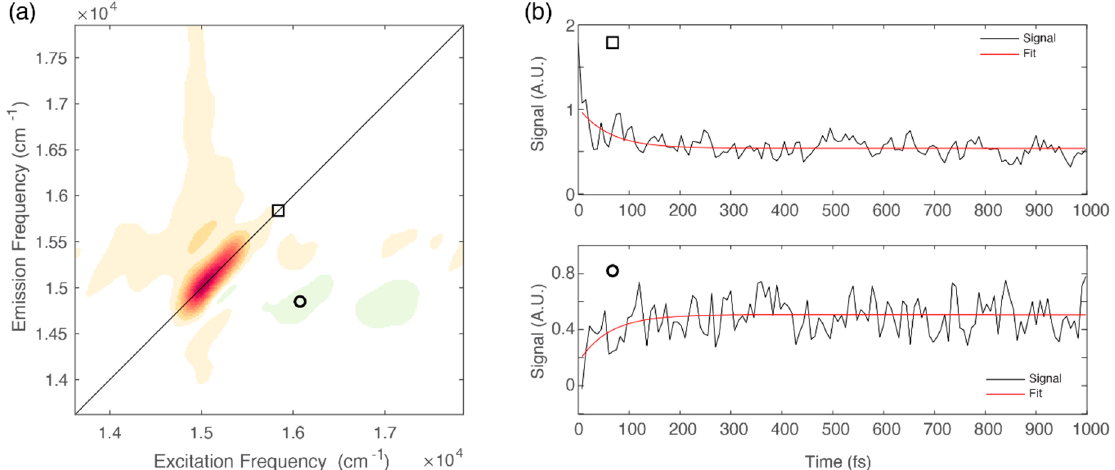
Figure 4. ( a ) 2D-DAS relative to the 60 fs component obtained for chl b at 77 K. The circle and the square markers pinpoint relevant diagonal and off-diagonal coordinates: (15,580, 15,580) and (14,900, 16,050) cm − 1 , respectively. ( b ) Signal decay extracted at relevant coordinates identified by the square (upper panel) and circle (lower panel).